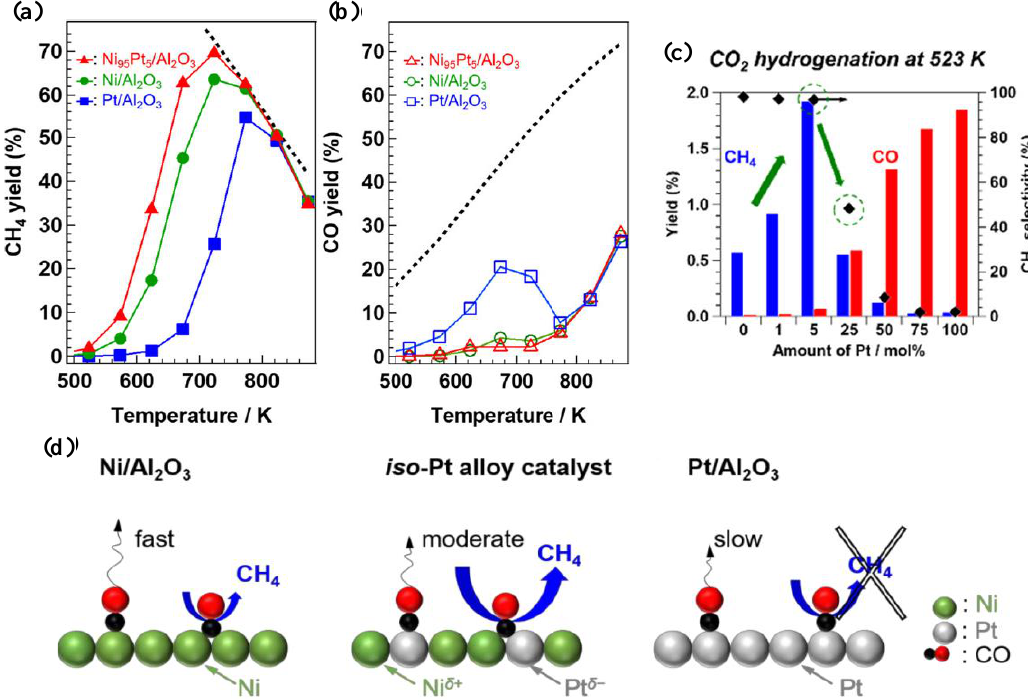
Figure 14. Yields of ( a ) CH 4 and ( b ) CO following hydrogenation of CO 2 over Ni−Pt/Al 2 O 3 , as well as ( c ) CH 4 yield and selectivity as a function of molar Pt percentage in the NiPt alloys; m cat = 100 mg, 10% CO 2 , and 40% H 2 in He (total flow rate = 50 mL min −1 ). ( d ) Illustration of the adsorbed species and the reactions taking place over Ni/Al 2 O 3 , the iso- Pt catalyst, and Pt/Al 2 O 3 during the hydrogenation of CO 2 . Reproduced with permission from [31,122]. Copyright: American Chemical Society, Washington, DC, USA, 2019, 2020.